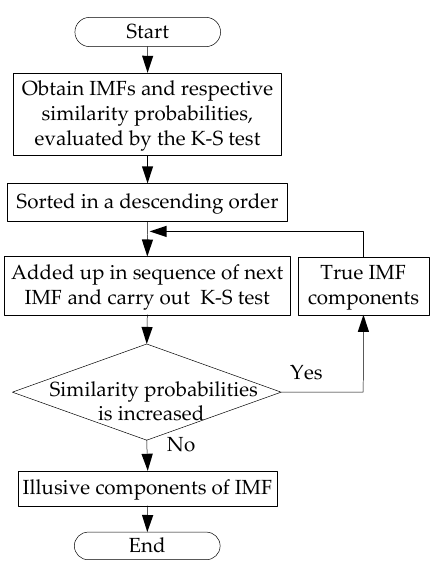
Figure 2. Judgment criterion of illusive components for a cumulative test.